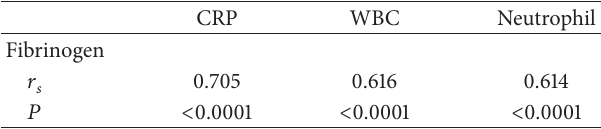
Table 3: Spearman correlation coefficients between fibrinogen and other inflammation markers in patients with